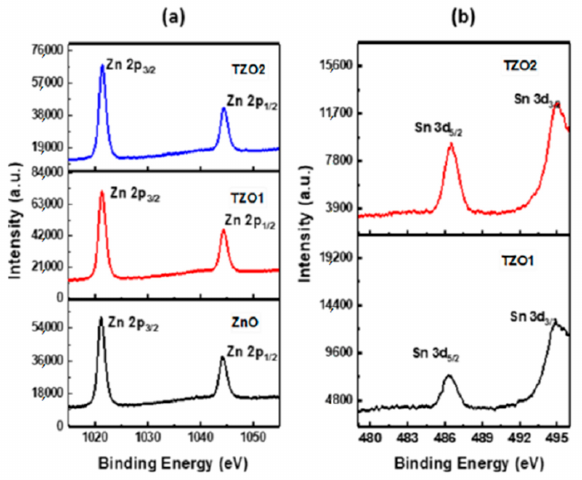
Figure 9. ( a ) XPS Zn 2p core level spectra of TZO1 and TZO2. ( b ) XPS Sn 3d spectra of TZO1 and TZO2. Reproduced with permission from Ref. [32]; published by Springer Nature,